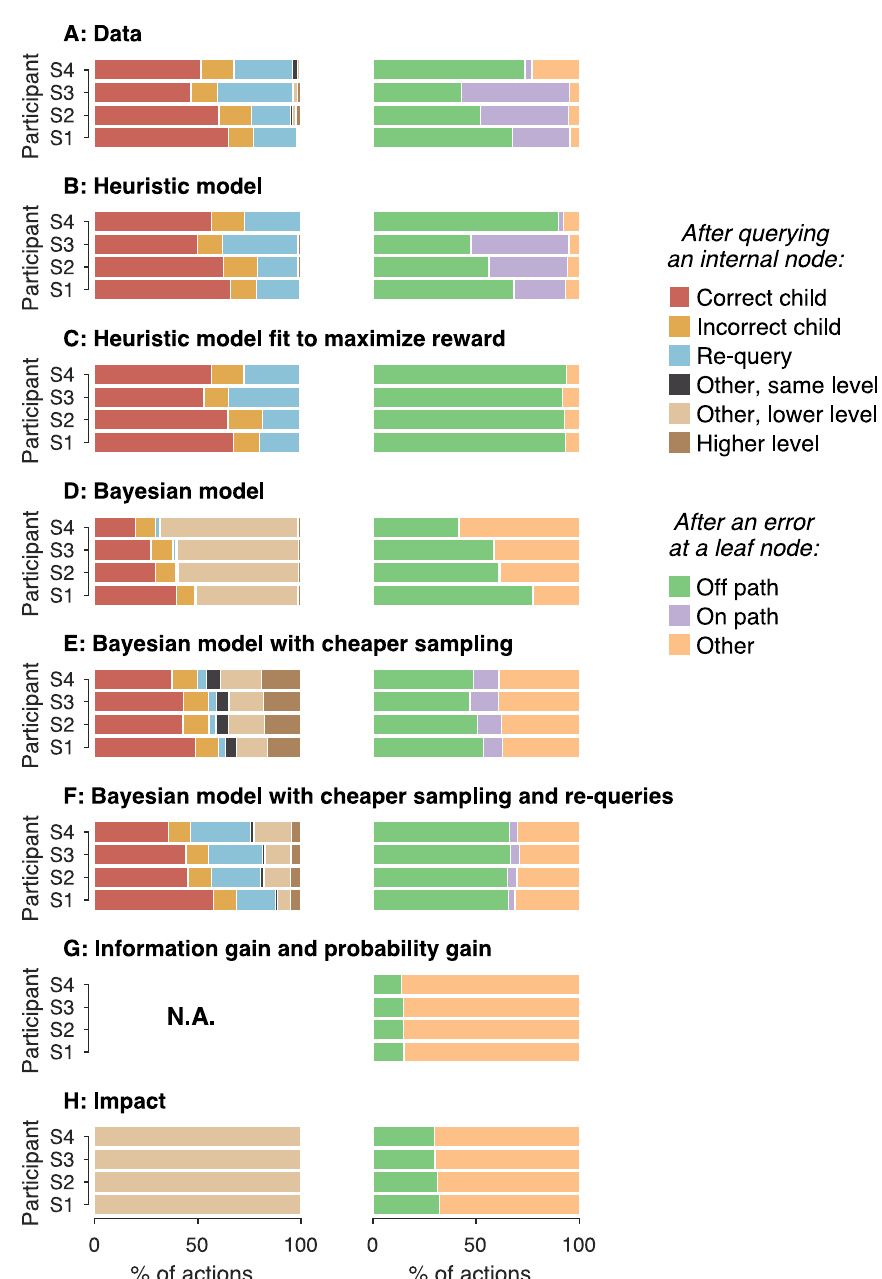
Fig 7. Distribution of actions after the query of internal and leaf nodes. The left column shows the types of action selected after a query of an internal node, and the right column shows those selected after an error at a leaf node. Panels A–H represent different datasets, identified in each panel. We sorted the actions that follow the query of an internal node into 3 categories: on-path queries, off-path queries, and queries that cannot be classified as neither on- nor off-path (‘other’). We sorted the actions that follow an error at a leaf node into 6 categories: choosing the child node that is in the true direction of motion (‘correct child’), the other child node (‘incorrect child’), querying the same node again (‘re-query’), other nodes at the same level excluding re-queries (‘other, same level’), nodes of lower level that are not direct child nodes (‘other, lower level’), and nodes located at higher levels of the decision tree (‘higher